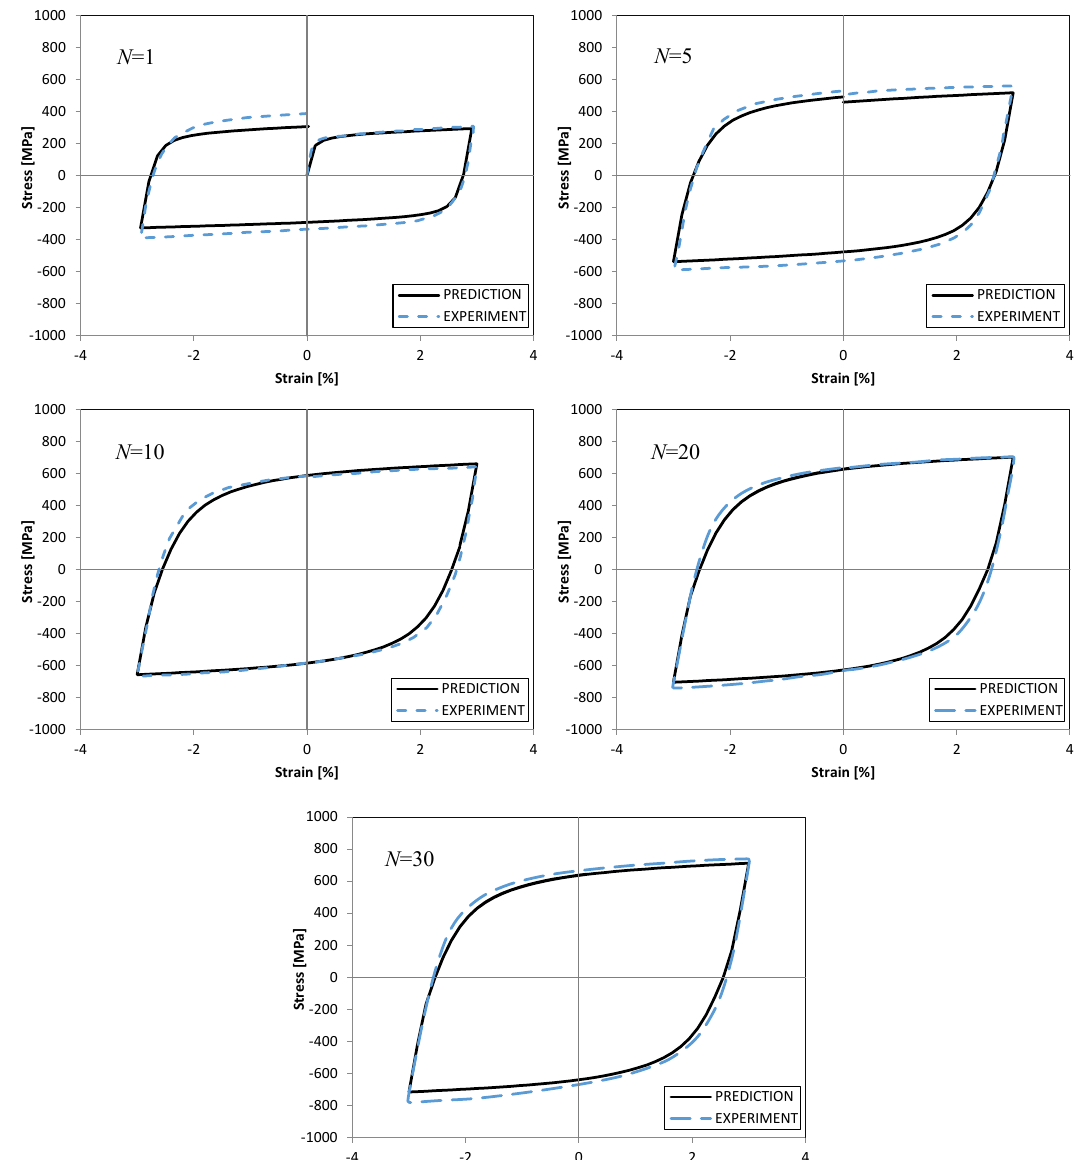
Figure 6. Prediction of the uniaxial test with ∆ (cid:101) = 6%(experimental data were taken from [15]).